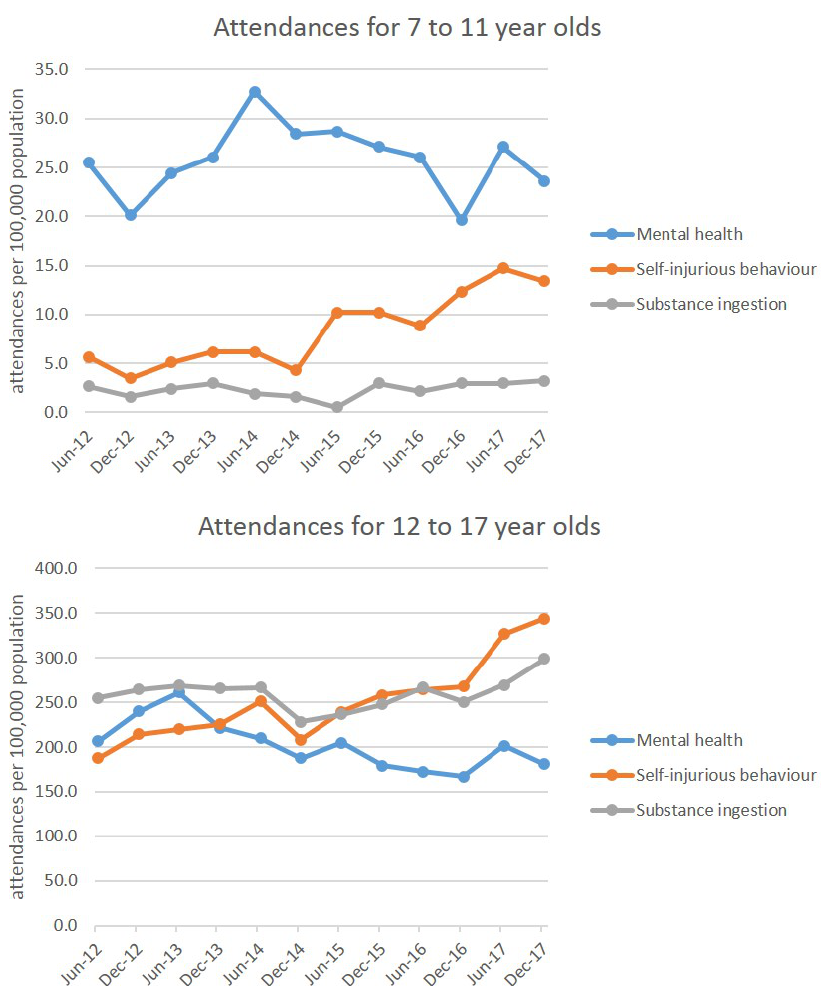
Figure 2. Ambulance attendances between June 2012 and December 2017 for a group aged 7–11 ( top